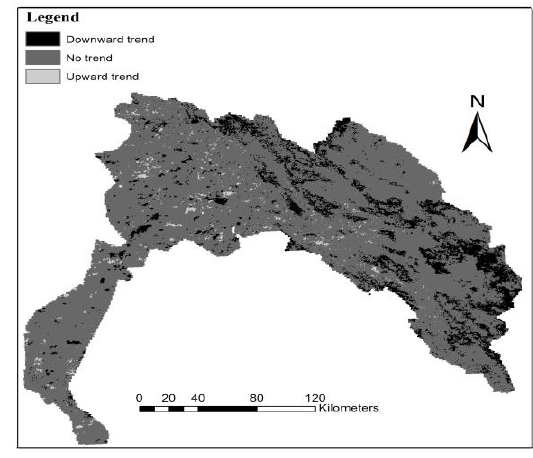
Figure 4. Mann-Kendal trend test on